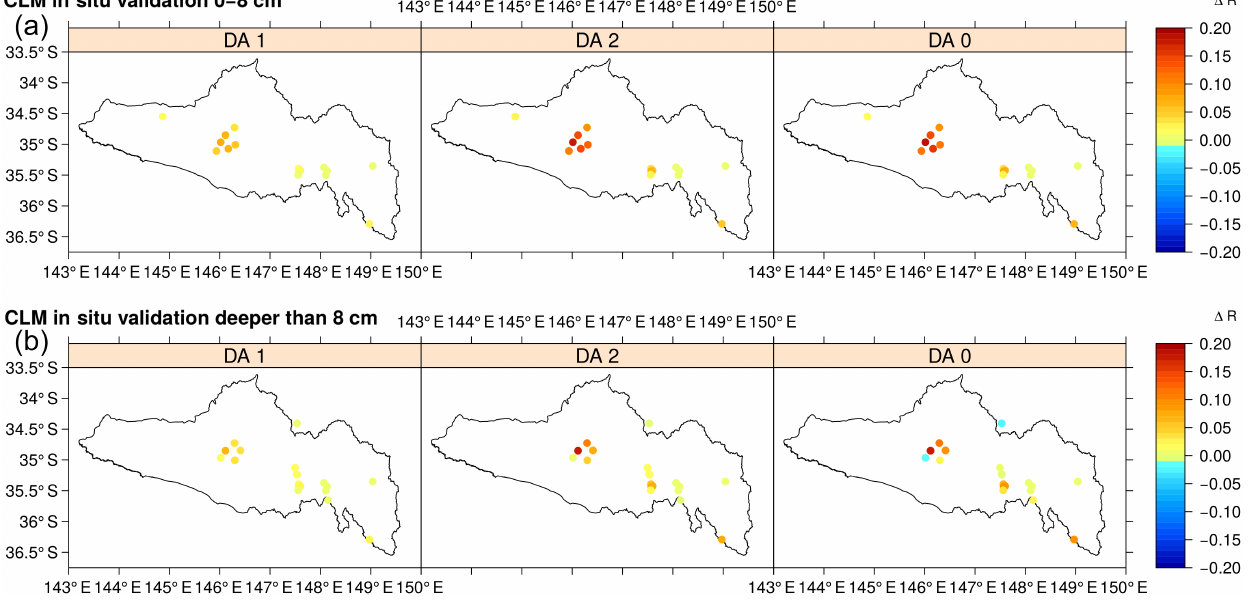
Figure 2. Change in correlation R for experiments DA 1, DA 2 and DA 0 both for top-layer soil moisture (a) as well as the root-zone soil moisture (b) within the Murrumbidgee catchment. In the case of multiple measurements at the same location, the weighted average of the measured as well as modelled soil moisture was computed in accordance with the corresponding CLM layer thickness.